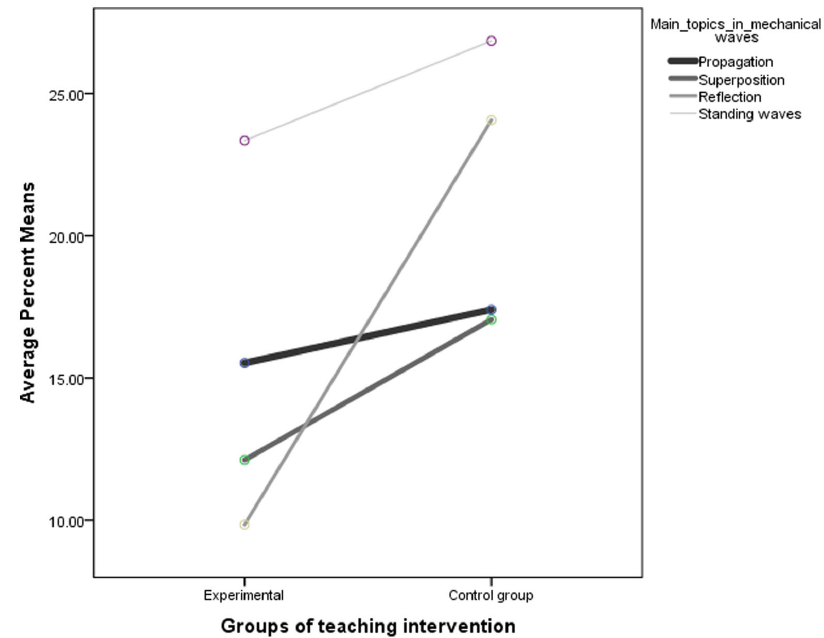
FIG. 2. Pre-test performance of experimental and control group in main topics of